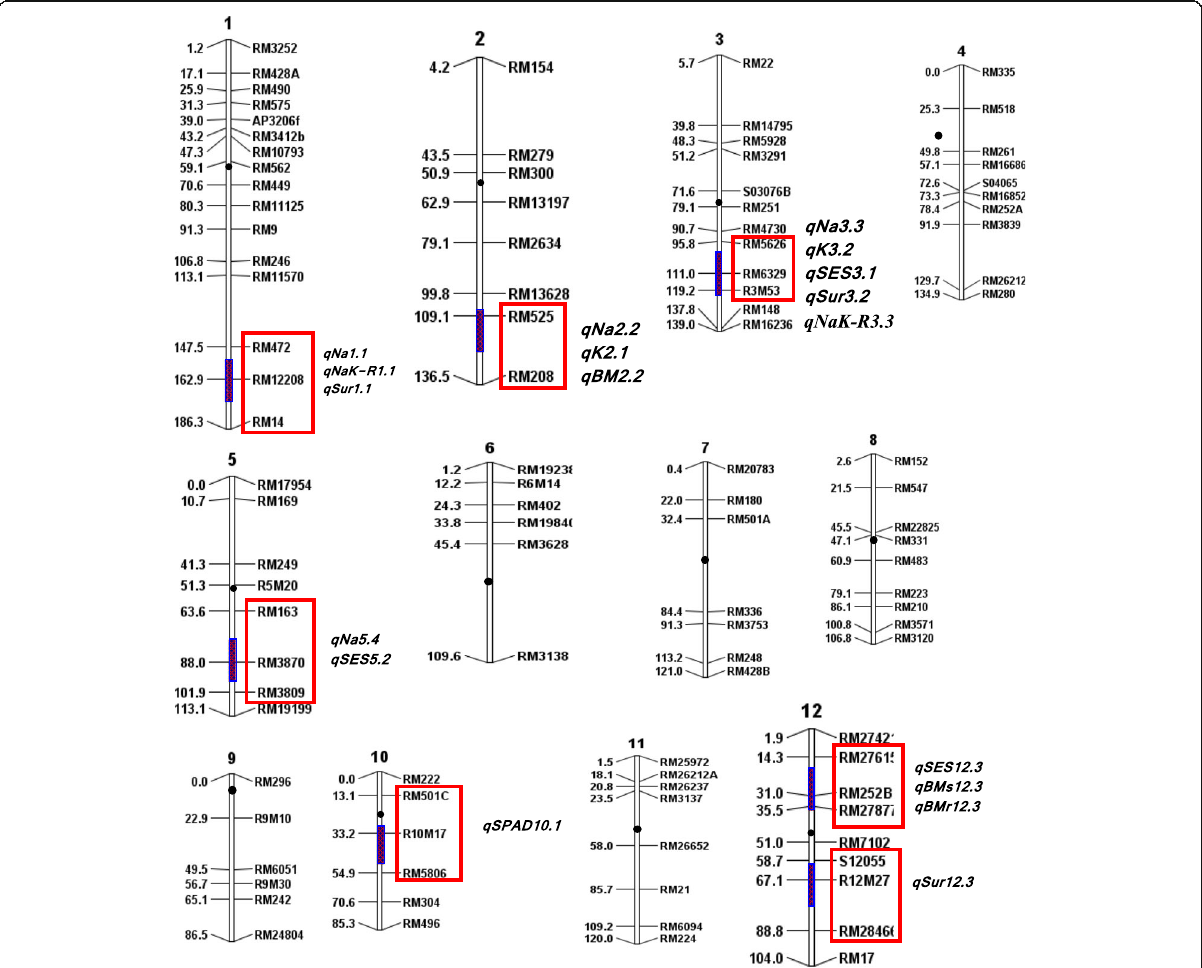
Fig. 2 A genetic linkage map of the 12 chromosomes of rice constructed based on selected individuals of an F 2:3 population of a cross between Capsule and BR29. The map was constructed using 105 SSR and InDel markers. The number at the top of each linkage group indicates the chromosome number. The names of the markers are listed at the right and the map distances between them (cM) are shown on the left of the chromosomes. Vertical bars on chromosomes 1, 2, 3, 5, 10 and 12 and the markers enclosed in red boxes indicate the approximate locations of the QTL detected for salinity